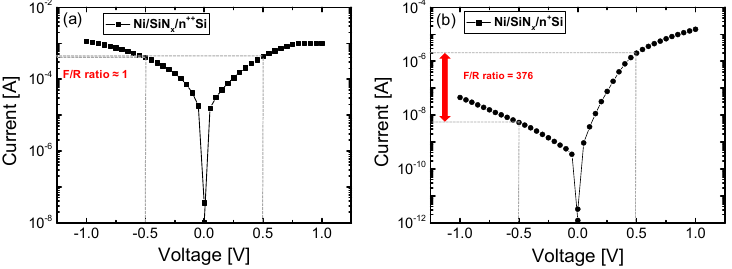
Figure 8. Forward-to-reverse ratio (F/R ratio) in the LRS for ( a ) the Ni/SiN x /n ++ Si device and ( b ) the Ni/SiN x /n + Si device.